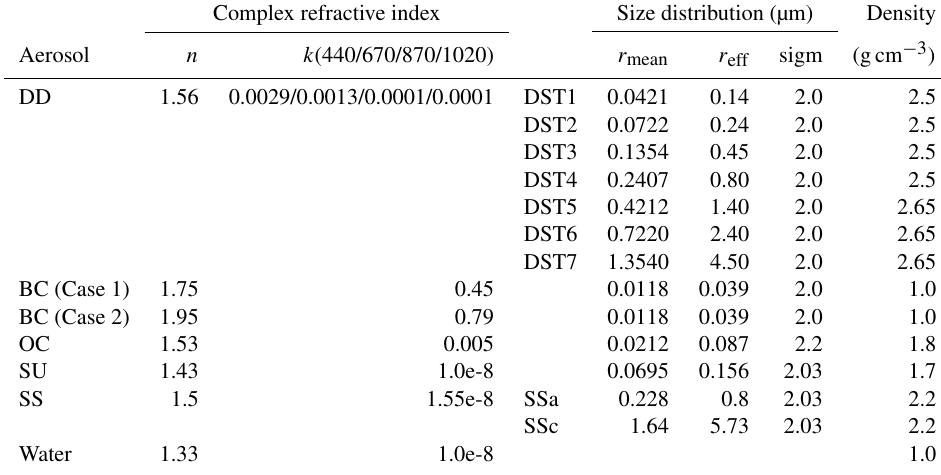
Table 1. Aerosol refractive index, size distribution and particle density for DD, BC, OC, SU, SS and host water employed in this